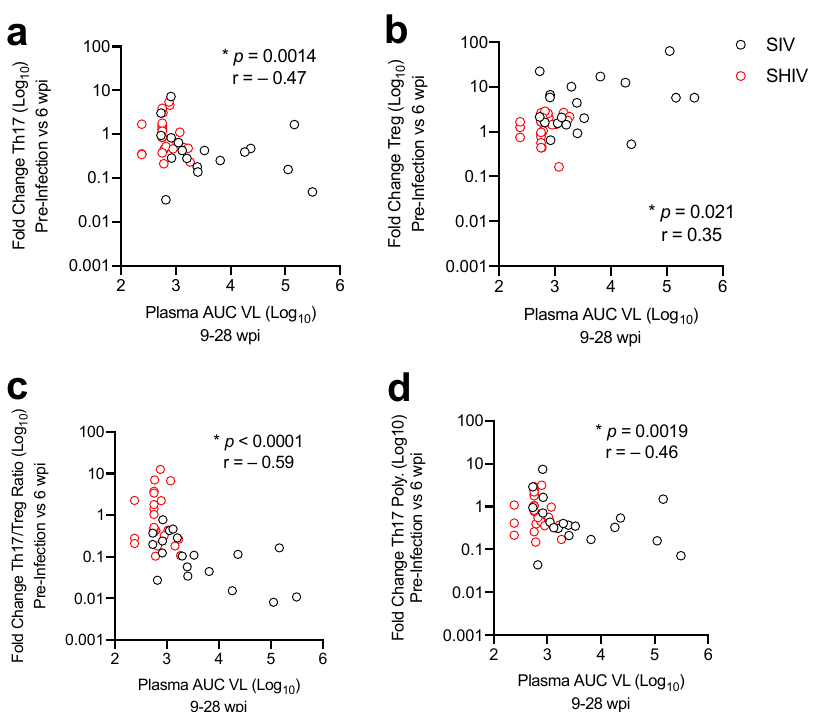
Figure 6. Less dysregulation of mucosal CD4 T-cells is associated with greater viral control during cART. Correlations between log10-fold change in colonic ( a ) Th17 and ( b ) Treg cell frequencies, ( c ) the Th17/ratio, and ( d ) Th17 polyfunctionality (Th17 Poly.) during acute infection (weeks 0–6) versus AUC plasma viremia during cART (weeks 9–28). Spearman’s rank correlation is shown, with * p -values ≤ 0.05 considered significant.